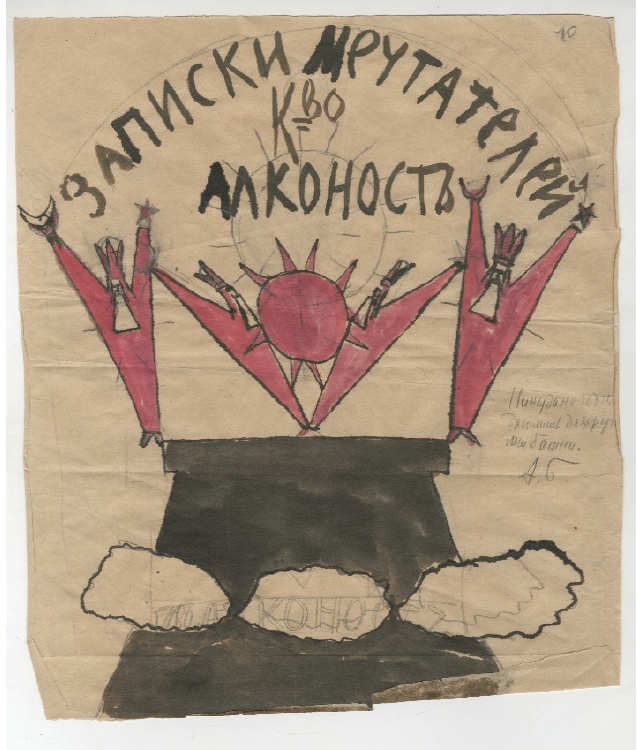
Figure 9. Bely’s sketch for the journal cover Dreamers’ Notes. 1918–1919. RGALI.